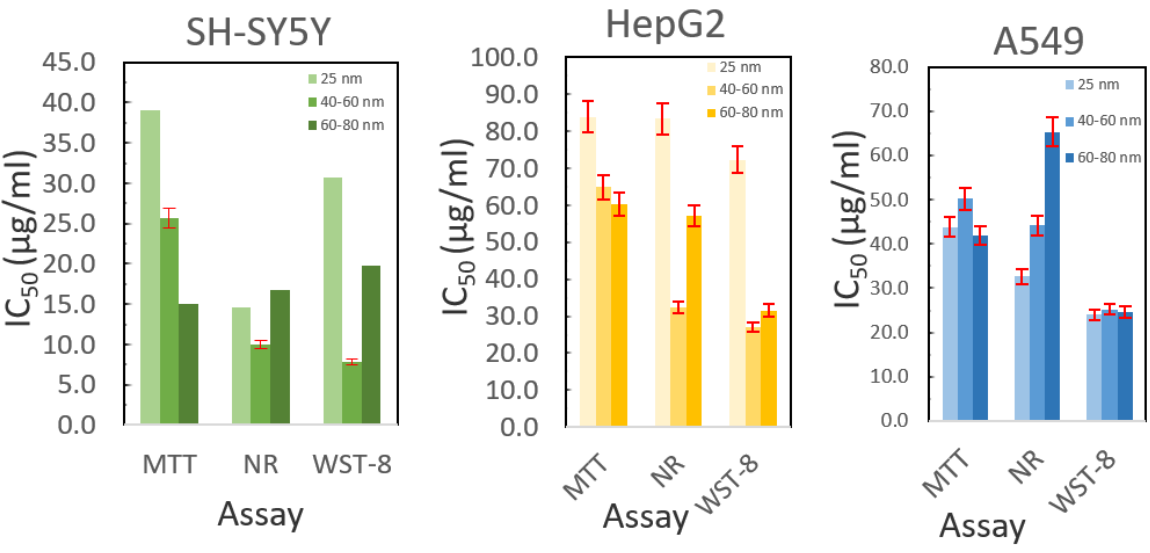
Figure 5. Cytotoxicity data for copper nanoparticles compared using three assays in three cell lines. Error bars are calculated as the standard error from three repetitions, each containing six replicates for each measurement.